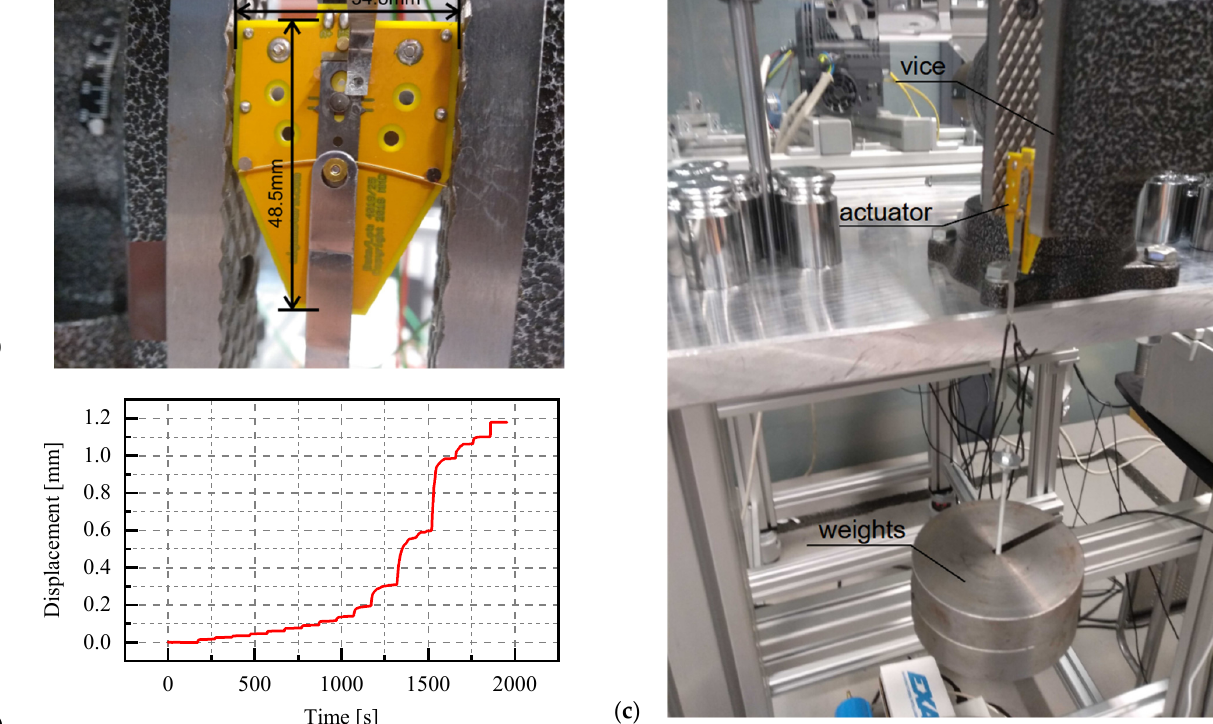
Figure 7. Experimental investigation of SMA actuator: ( a ) dimensions of the Miga iNITIator-062-010 actuator; ( b ) example of a graph showing displacement versus time; ( c ) Actuator during measure- ment.